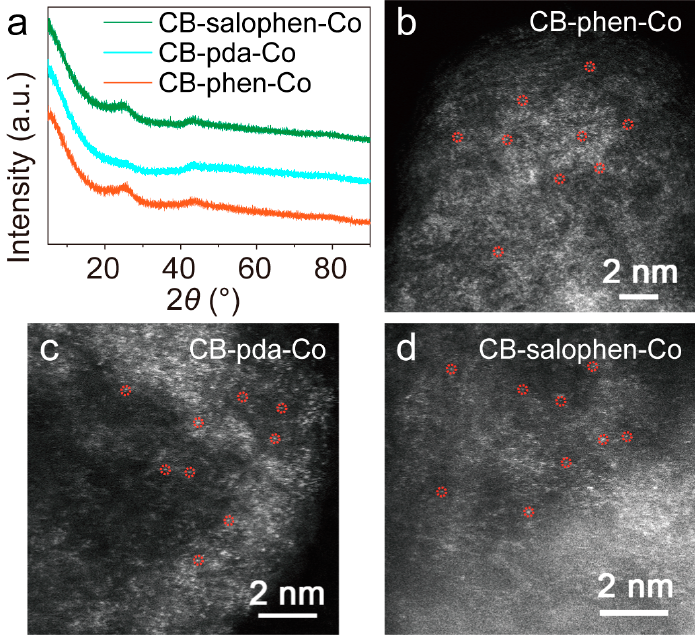
Figure 1. Characterization of CB-conjugated complexes. ( a ) XRD patterns. HAADF-STEM images of ( b ) CB-phen-Co, ( c ) CB-pda-Co, and ( d ) CB-salophen-Co.